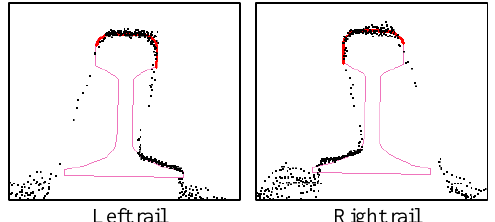
Figure 8. An example of the rail extraction (cross section)